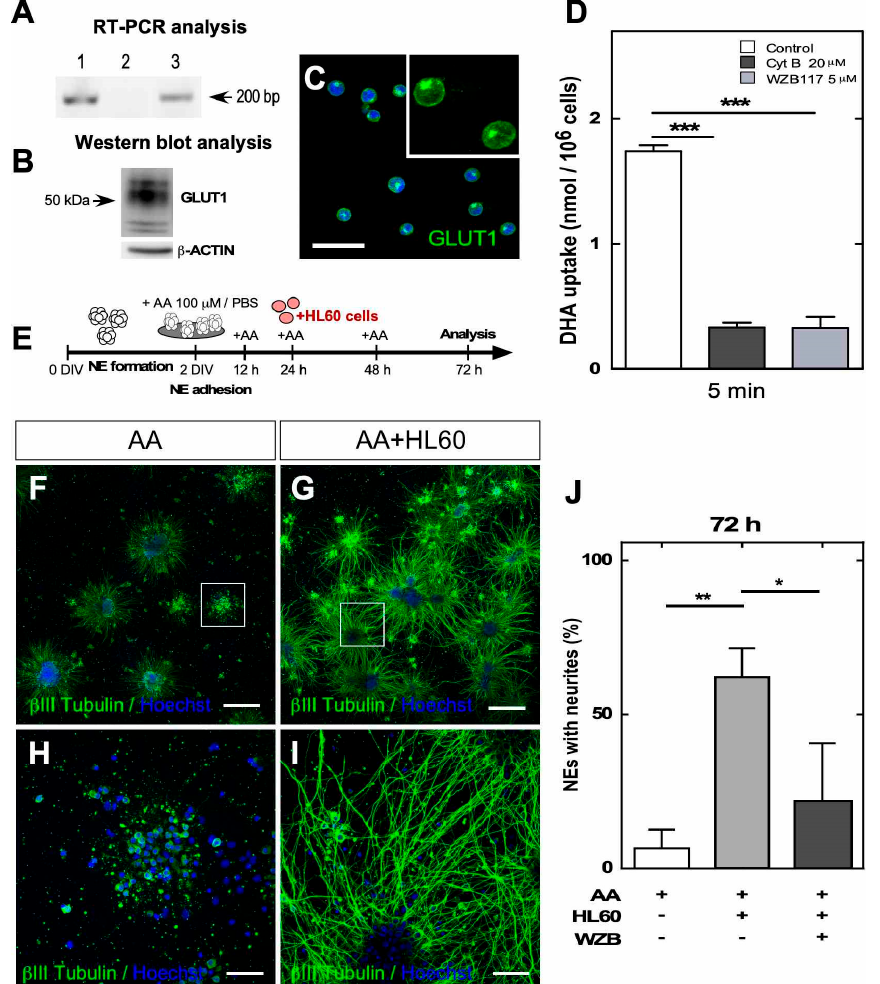
Figure 4. Coculture of HL60 cells with NEs maintained neurites in vitro after AA treatment. ( A ) PCR analysis of GLUT1 mRNA. RNA extracts obtained from HL60 cells (line 1), negative RT-PCR control (line 2), and positive control using human U87 cell line samples (line 3). ( B ) Western blot analysis for GLUT1 expression in HL60 cells. ( C ) GLUT1 immunocytochemical detection in HL60 cells. Scale bar, 30 µ m. ( D ) Uptake of 100 µ M DHA for 5 min in the presence of Na + , 20 µ M cytochalasin B or 5 µ M WZB117 (GLUT1 specific inhibitor). All data are representative of three separate experiments. Statistical analysis, parametric ANOVA test, followed by Tukey’s test, *** p < 0.001. ( E ) Protocol used to recycle vitamin C with HL60 cells. ( F , G ) Immunocytochemistry analysis of β III tubulin in neurospheres treated with AA for 72 h without ( F ) or cocultured with HL60 cells after 24 h of treatment ( G ). Scale bar, 100 µ m. ( H , I ) High-power image of NEs depicted in ( F , G ), respectively. Scale bar, 50 µ m. ( J ) Quantification of the neurites of NEs until 72 h of treatment with 100 µ M AA in the presence of HL60 cells or the WZB117 inhibitor (WZB). All data are representative of three separate experiments. Statistical analysis, parametric ANOVA test, followed by Tukey’s test, * p < 0.05; ** p < 0.01.